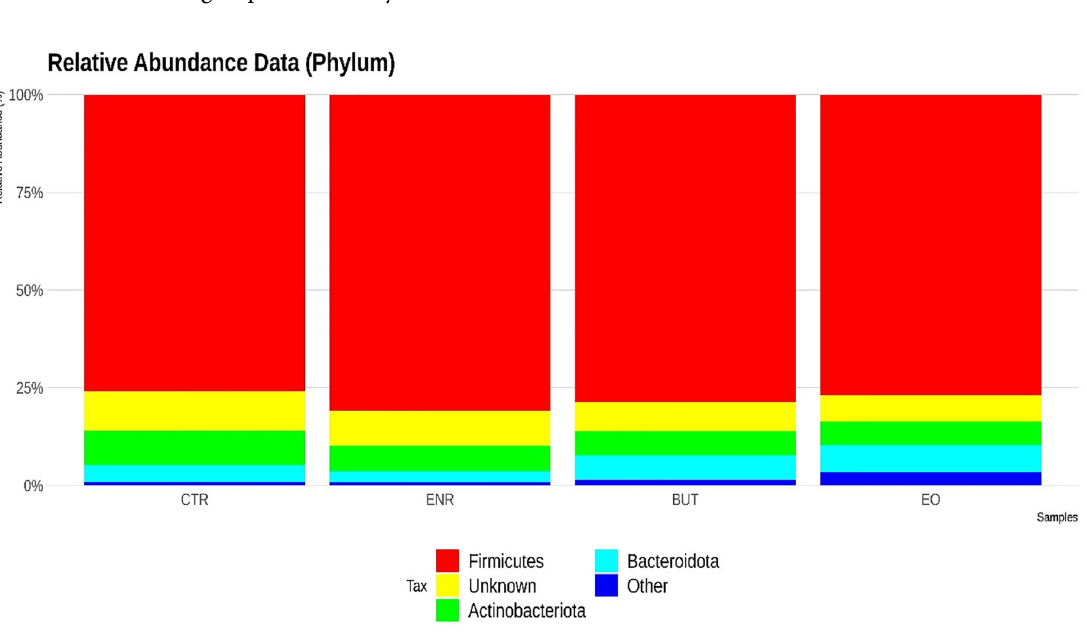
Fig 1. Classification of the most abundant bacterial communities in the samples, through the recognition of amplicon sequence variants (ASVs). Each color represents a different